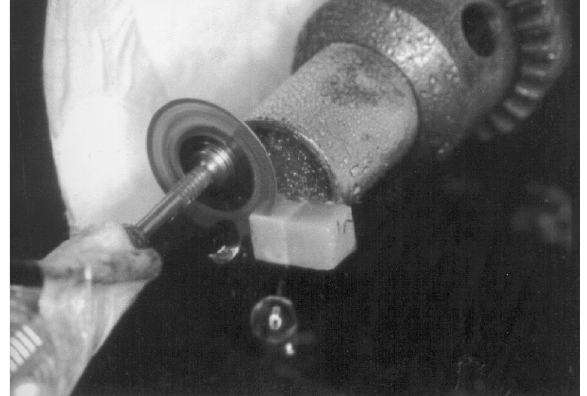
FIGURE 4- Initial cut to eliminate excess of cement on the lateral surface